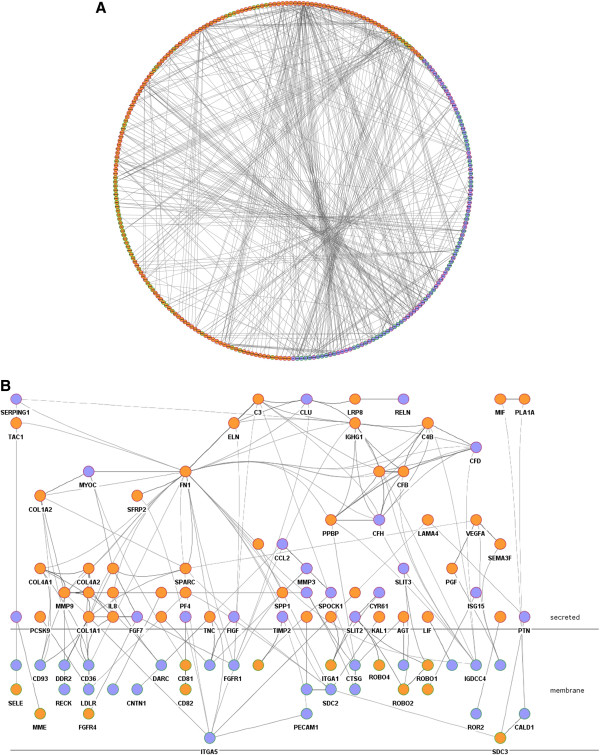
Crosstalk pathway. A. Circular layout of protein-protein interaction network representing interactions (lines) between over-expressed genes in adjacent mucosa (purple) and in tumor (orange). Nodes with a green border symbolize membrane proteins whereas red were used to represent secreted proteins B. Abstraction of the network in which only crosstalk interactions were drawn, using Cerebral view from Cytoscape.